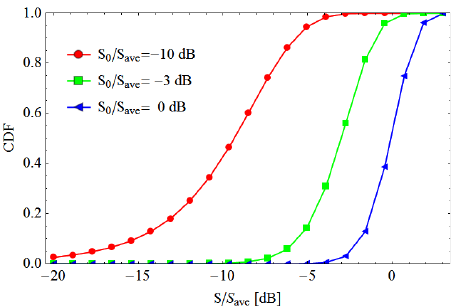
Figure 1. Cumulative distribution of the desired signal power for ρ = 0.98, and for three different values of S 0 / S ave . Relative realized signal powers S / S ave dB are on the x